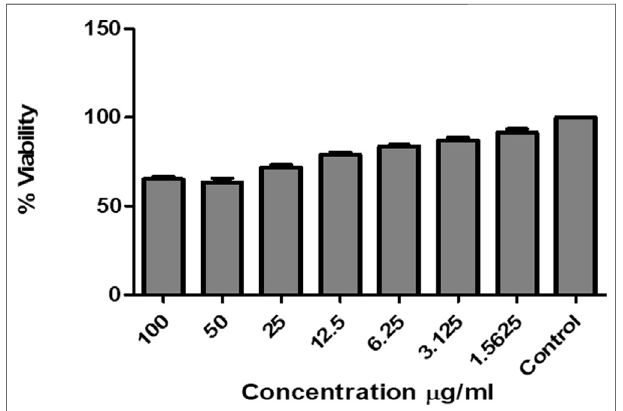
FIGURE 7 | Effect of Pseudevernia furfuracea 70% methanol extract on HEK 293Tcell lines.